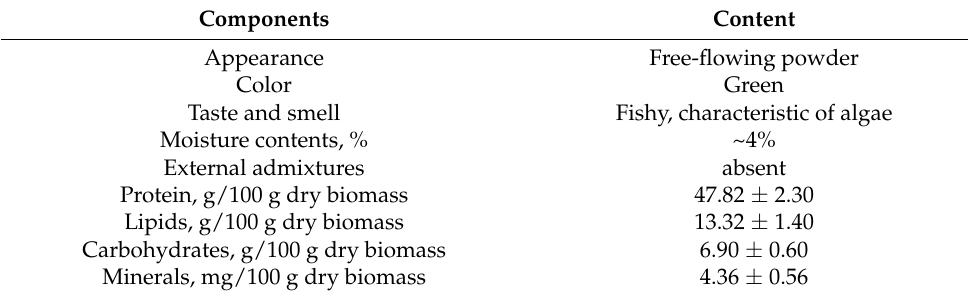
Table 1. Specifications and chemical composition of microalgae biomass C. sorokiniana